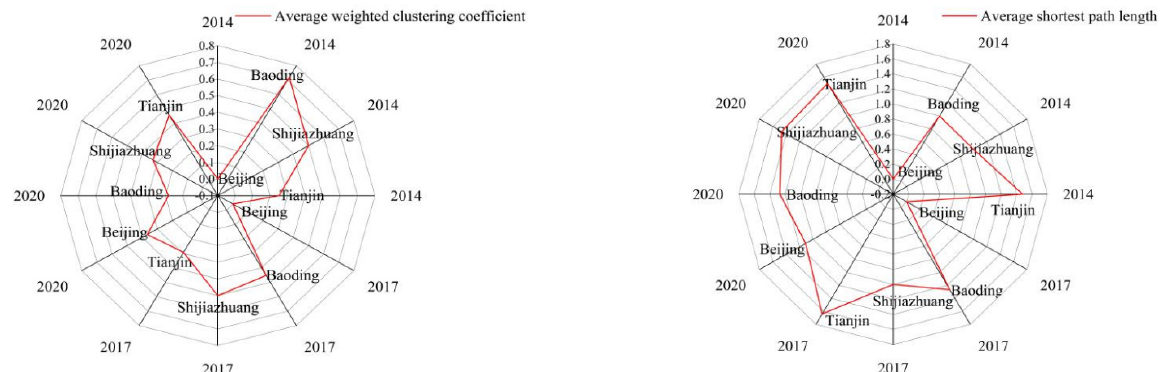
Figure 8. Comparison of the characteristics of the HSR networks in four cities.